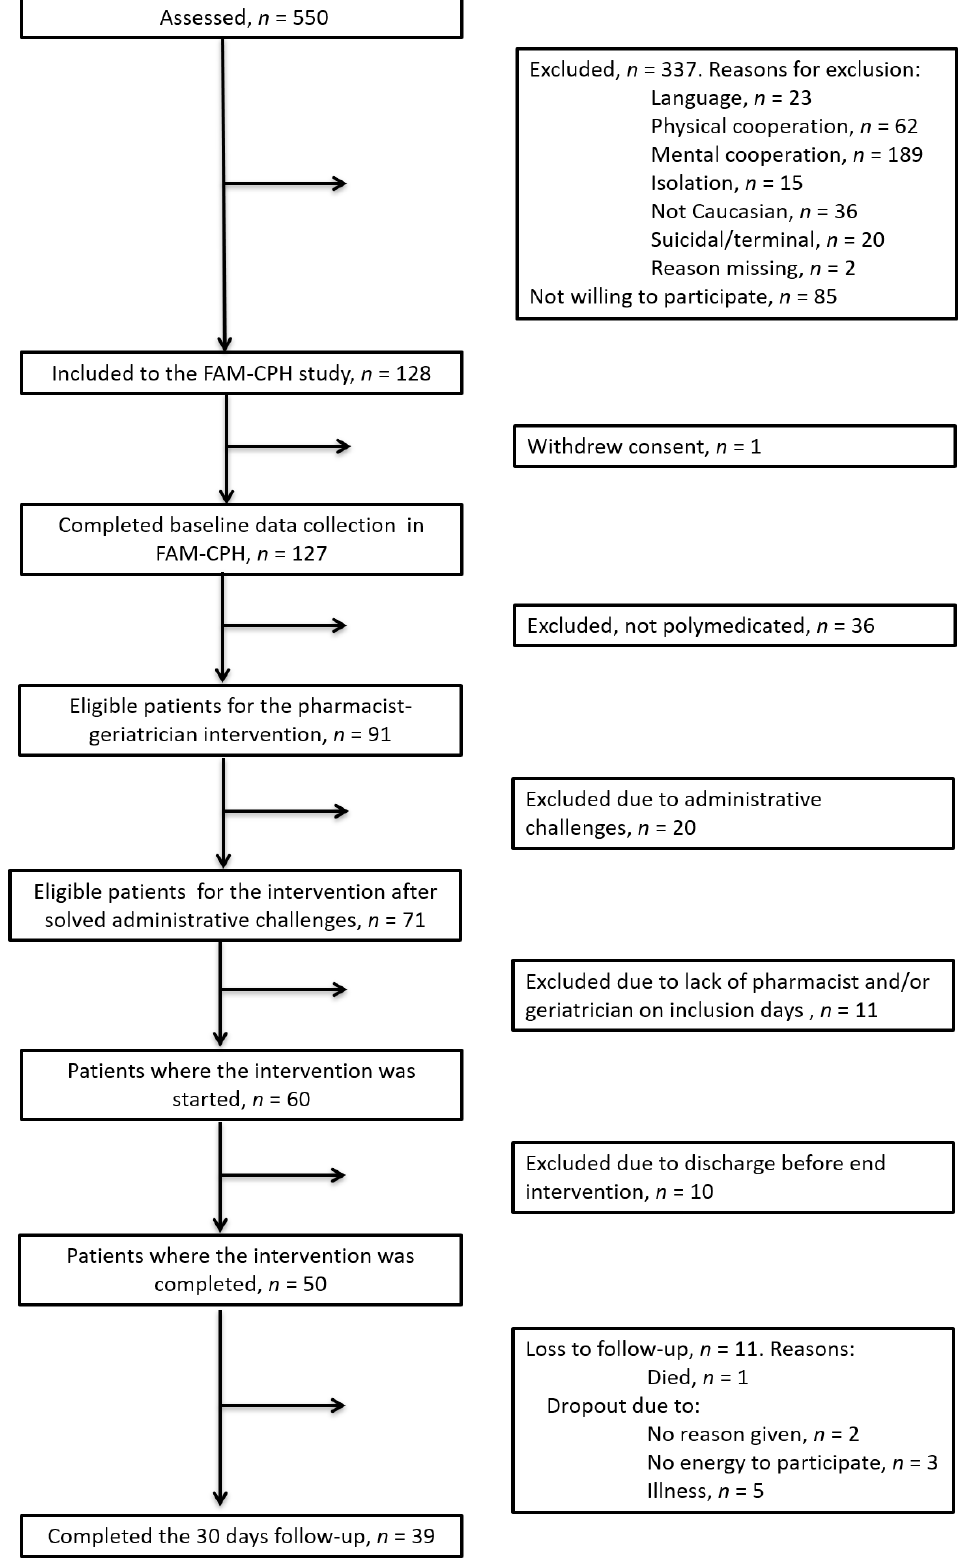
Figure 1. Flowchart of inclusion of patients in the study. In total, 39 patients completed the 30 days follow-up.